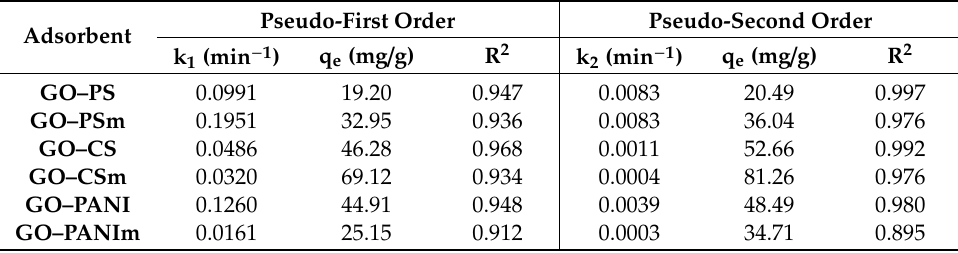
Figure 10. Pseudo-first and pseudo-second order kinetic model fitting. Table 2. Kinetic parameters for the adsorption of bisphenol–A (BPA) onto GO-polymer composites.